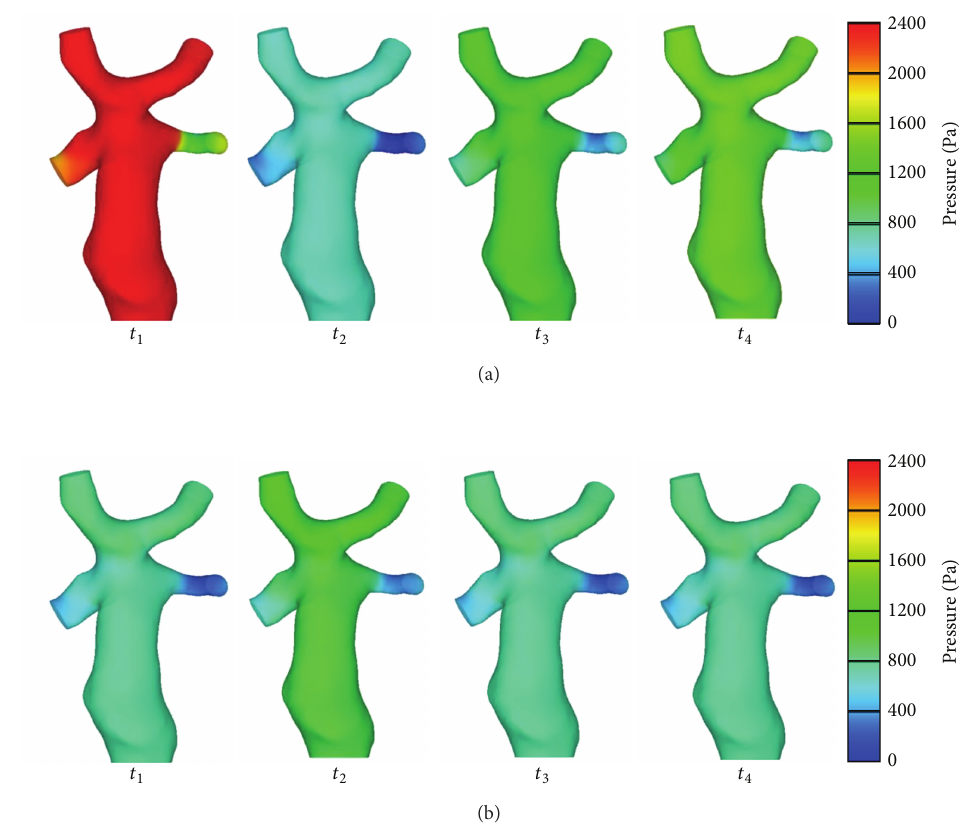
Figure 7: Pressure distribution (Condition II (a) and Condition I